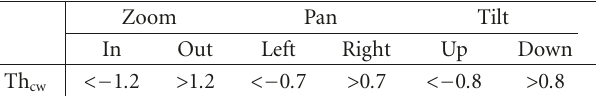
Table 1: Camera work categories and corresponding error thresh- hold